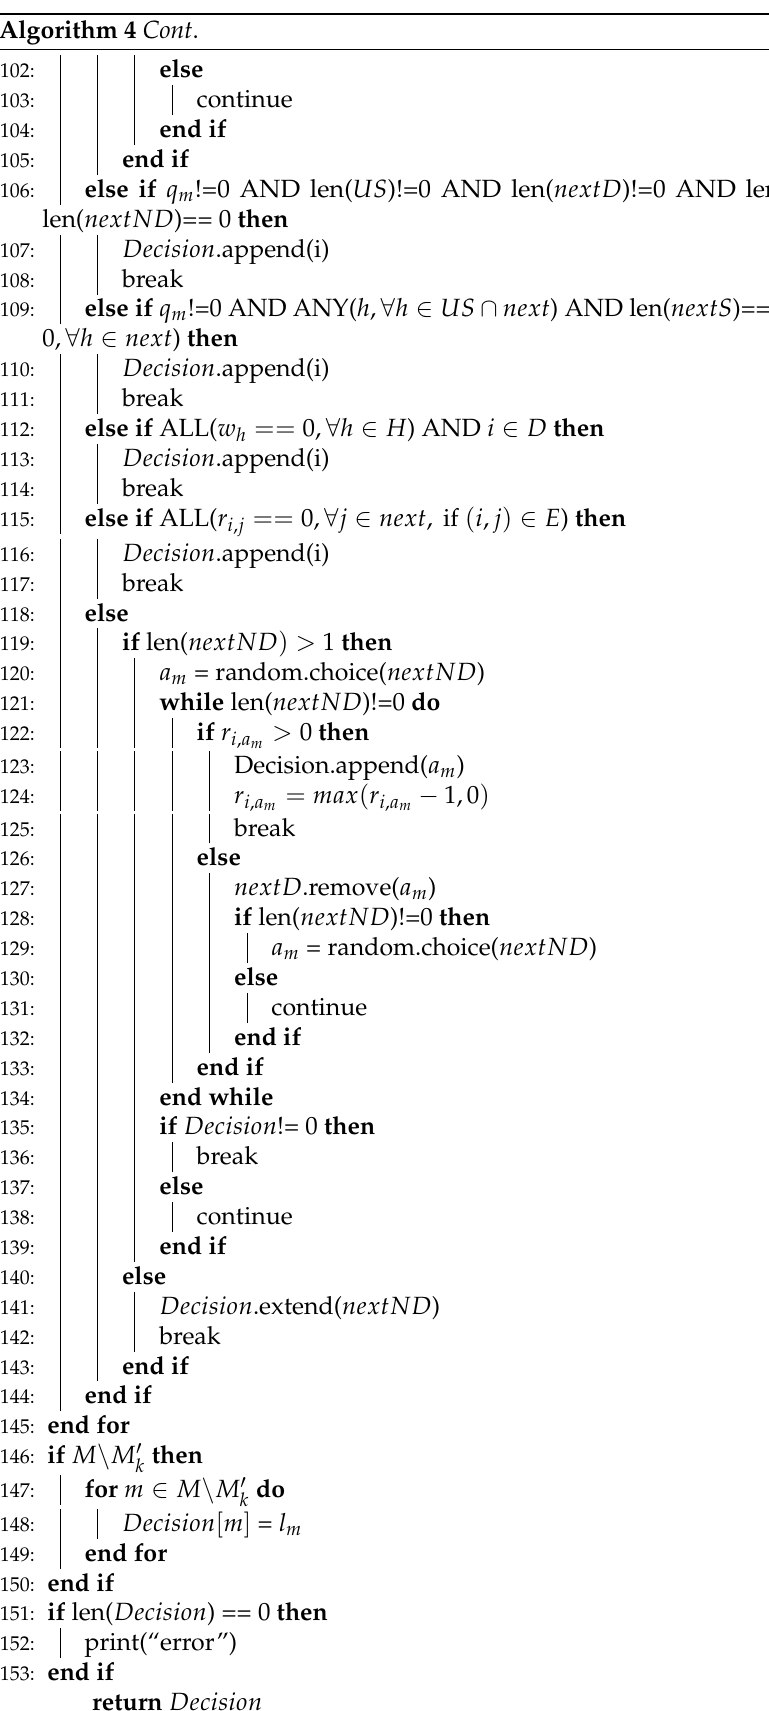
Algorithm 4 Cont